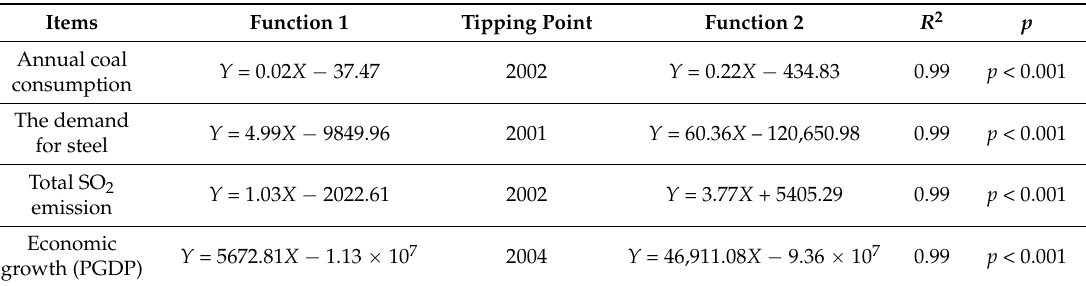
Table 1. The statistical descriptions of annual coal consumption, the demand for steel, the total SO 2 emission, and the economic growth